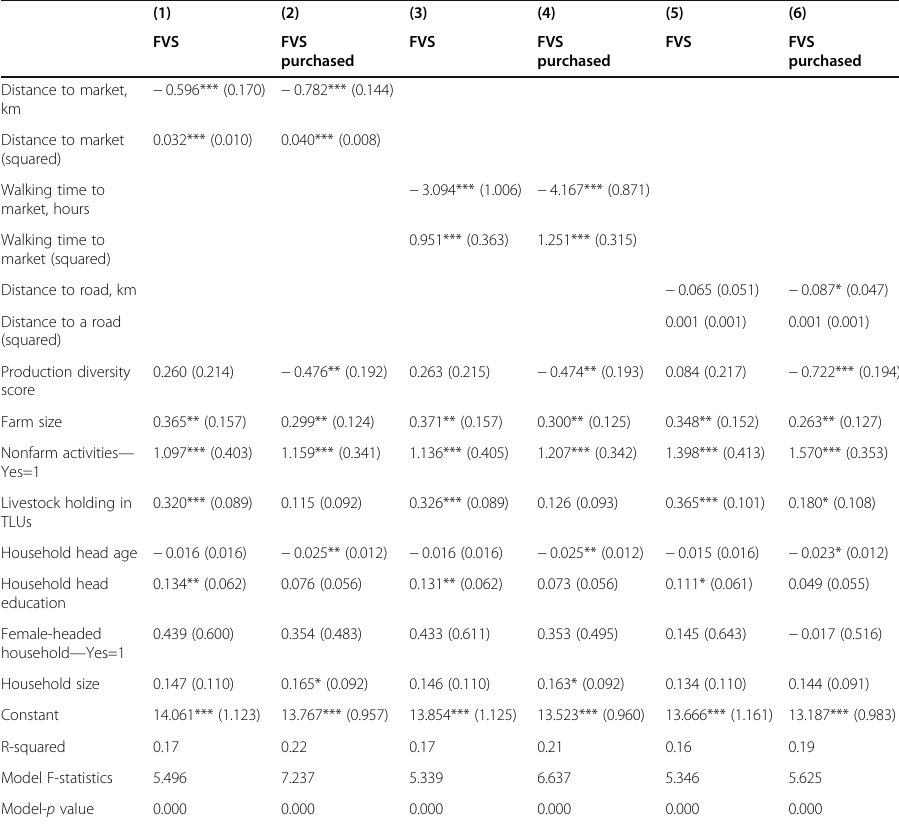
Table 3 Association between Market Access and Food Variety Score (FVS) for 324 smallholder households